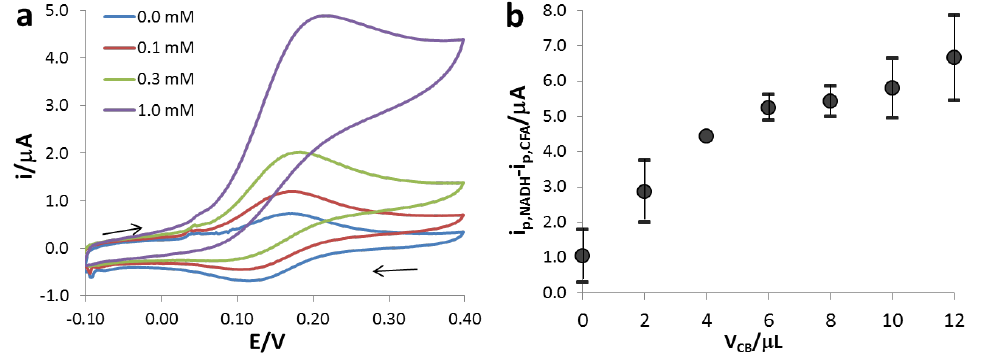
Figure 3. ( a ) Typical CV responses of CFA/CB/SPEs in 0.1 M PB (pH 7.0), 0.1 M KCl in the absence (blue line) and in the presence of different NADH concentrations: 0.1 mM (red line), 0.3 mM (green line) and 1.0 mM (purple line); 0.02 V·s −1 potential scan rate. ( b ) Trend of 1 mM NADH (i p,NADH ), subtracted by the relevant background signal (i p,CFA ), vs. the volume of CB dispersion deposited on CFA el /CB/SPEs. The error bar length accounts for two-times the standard deviation, computed by considering results coming from three similar CFA el